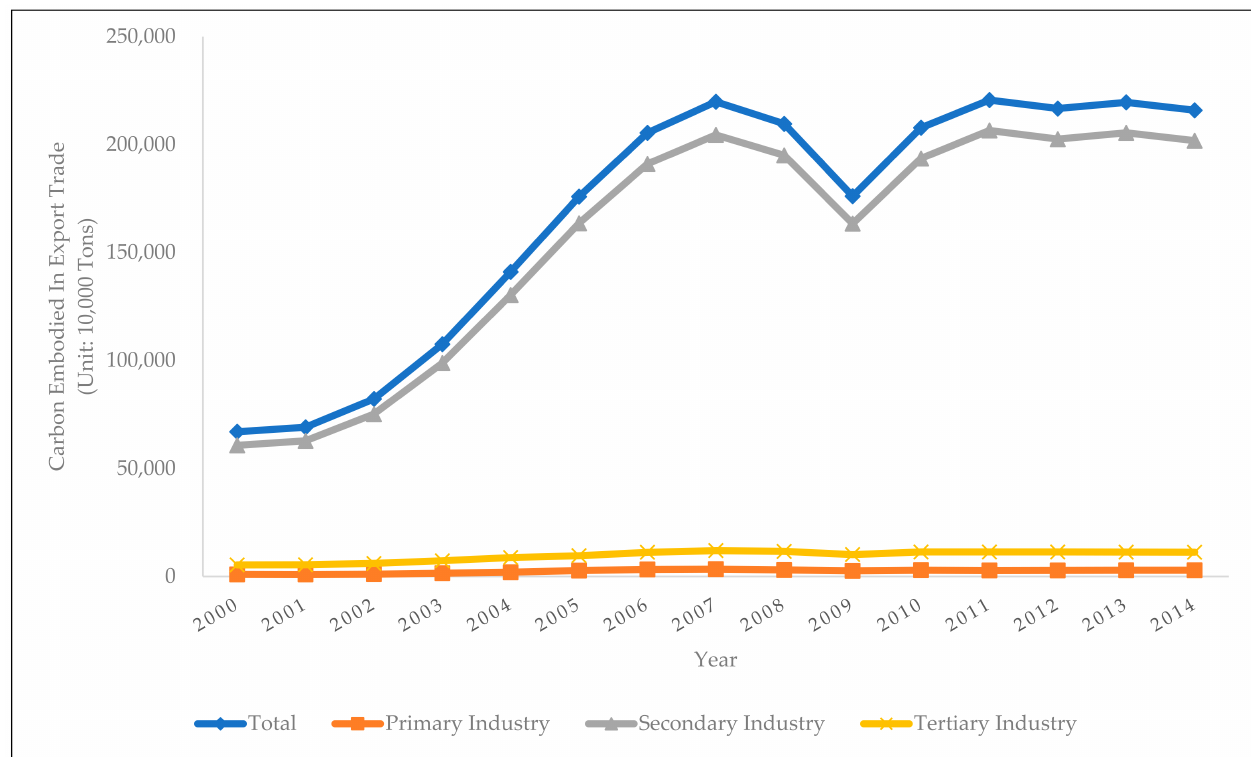
Figure 1. China’s Export Trade Embodied Carbon and Its Distribution Across Three Main